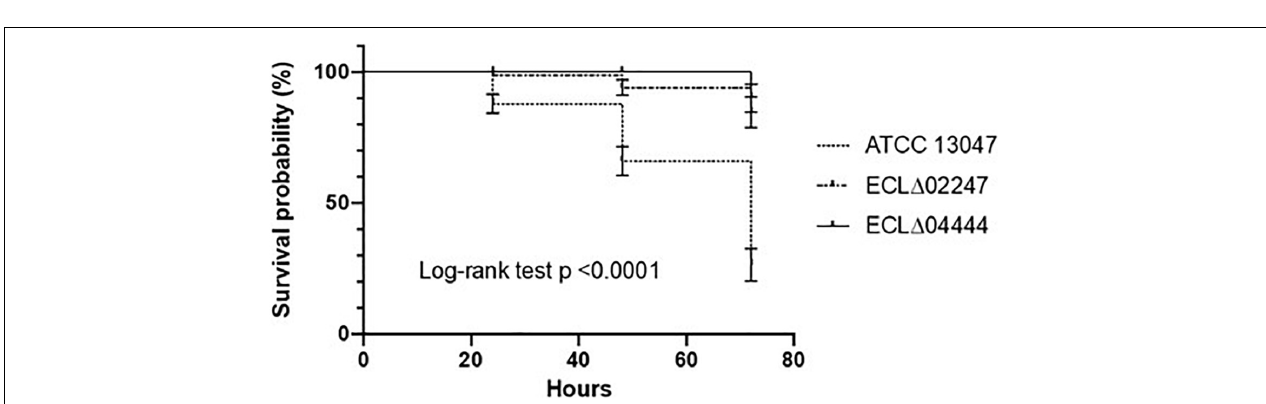
FIGURE 3 | Competition assays of the different mutant strains (kanamycin resistant) competed with the wild-type E. cloacae ATCC 13047 when both strains were inoculated together (50/50%) (around 3 × 10 5 CFU/larvae). Bars represent the percentage of the mutant cells numbered after 48 h into the larvae of G. mellonella . Results are the average of, at least, three independent experiments and the represent the mean ± standard deviation.